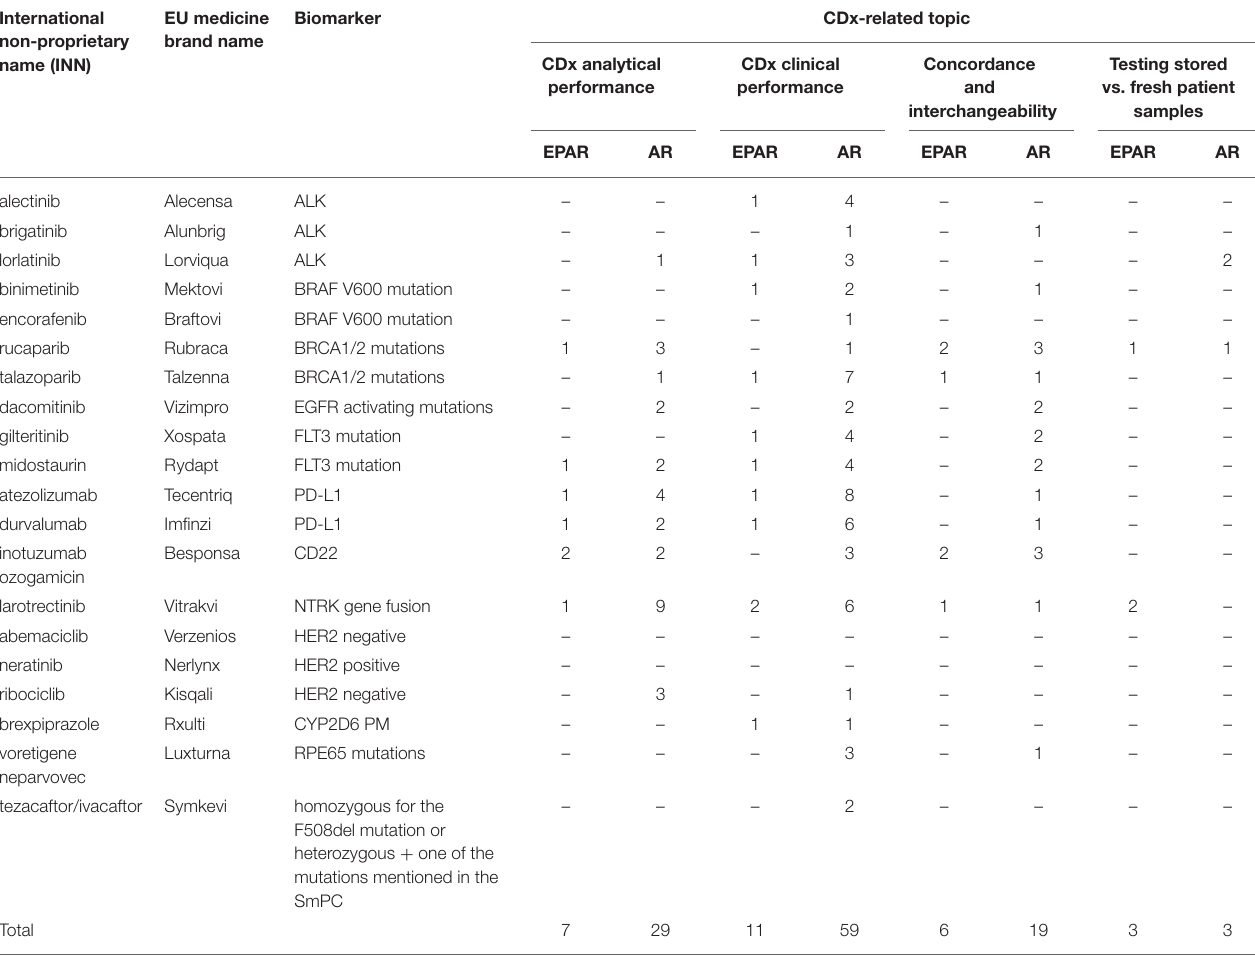
TABLE 1 | Discussion of CDx analytical performance, clinical performance, concordance and interchangeability, and testing of stored vs. fresh patient samples in the EPARs and ARs of the 20 selected